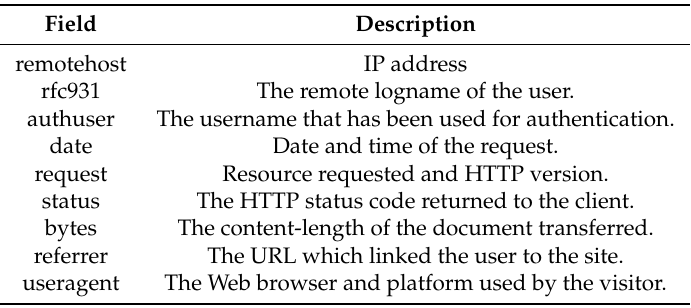
Table 1. NSCA Common Log Format